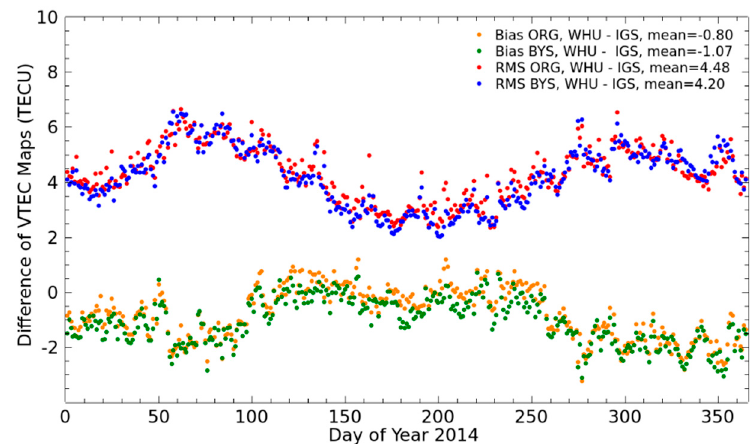
Figure 5. Differences between VTEC maps and The Ionosphere Working Group of the International GNSS Service (IGS) final global ionospheric maps (GIMs). The red and blue points show the RMSs of differences in VTEC maps based on original least-squares estimation (LSE) or Bayesian estimation, respectively, compared with IGS final GIMs.